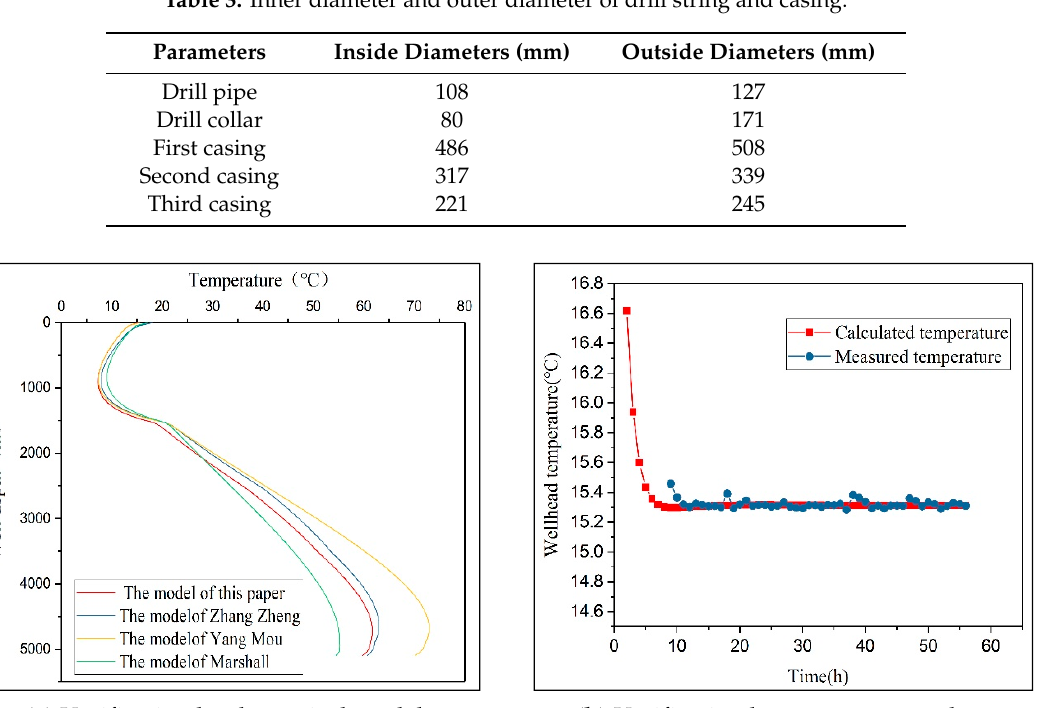
Table 3. Inner diameter and outer diameter of drill string and casing.